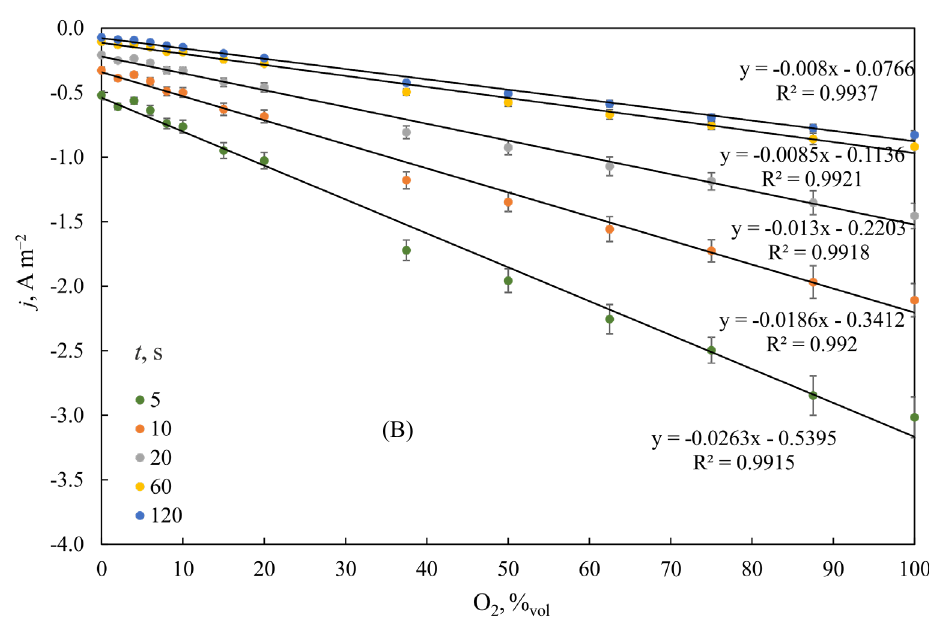
Fig. 7. (A) The dependence of the current density j on the time t at different partial pressures of oxygen and (B) the dependence of the current density on the oxygen concentration at different moments during the chronoamperometry. The potential of the platinum electrode was stepped from 0.5 V to −0.3 V vs Ag|AgCl|0.1 M KCl, the 0.1 M KCl solution was saturated with mixture of nitrogen and oxygen ( p tot = 101 kPa) and the pumping speed of the solution was 2 cm 3 min −1 using DropSens 550 Screen-Printed Electrochemical Array as